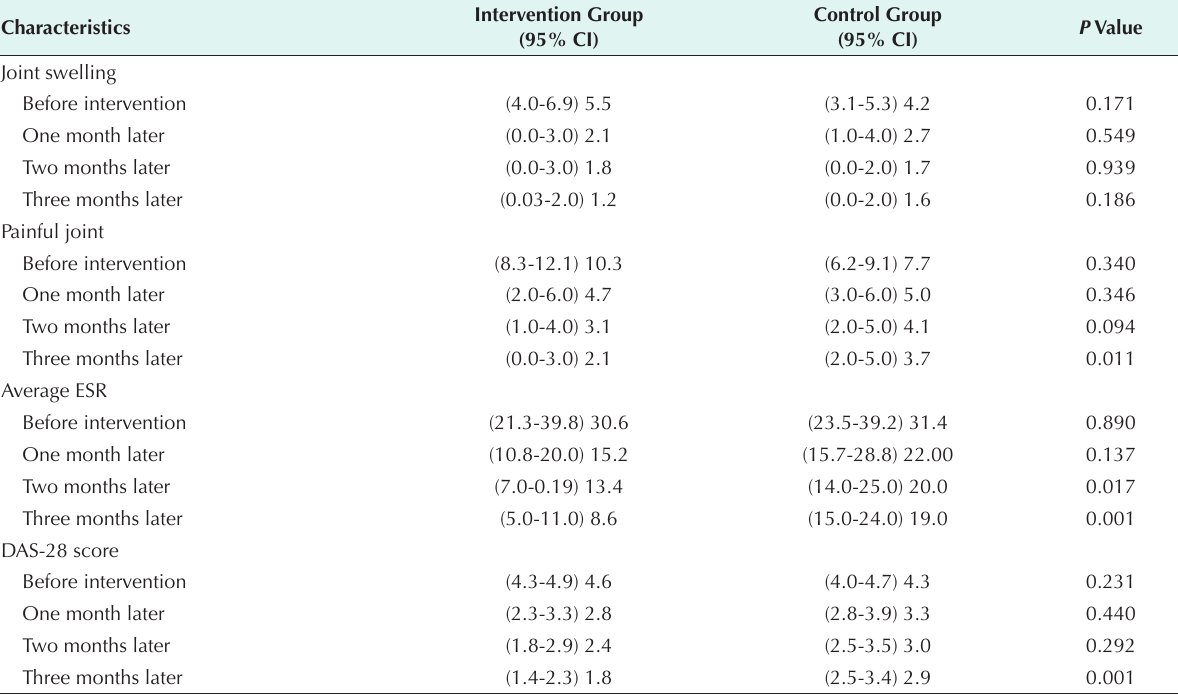
Table 2. Comparison of Joint Involvement Indices in Intervention and Control Groups